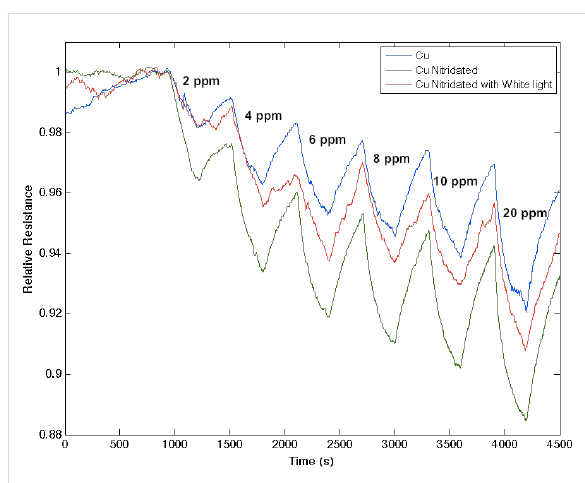
Figure 4: Response corresponding to decreasing resistance as NH 3 contributes electrons to a Cu x O-treated porous silicon (blue) and nitri- dated Cu x O-nanostructure-treated PS (green). The nitridated Cu x O- treated interface is basic relative to the PS and Cu x O-treated PS acidic sites. This interface becomes more acidic upon exposure to white light